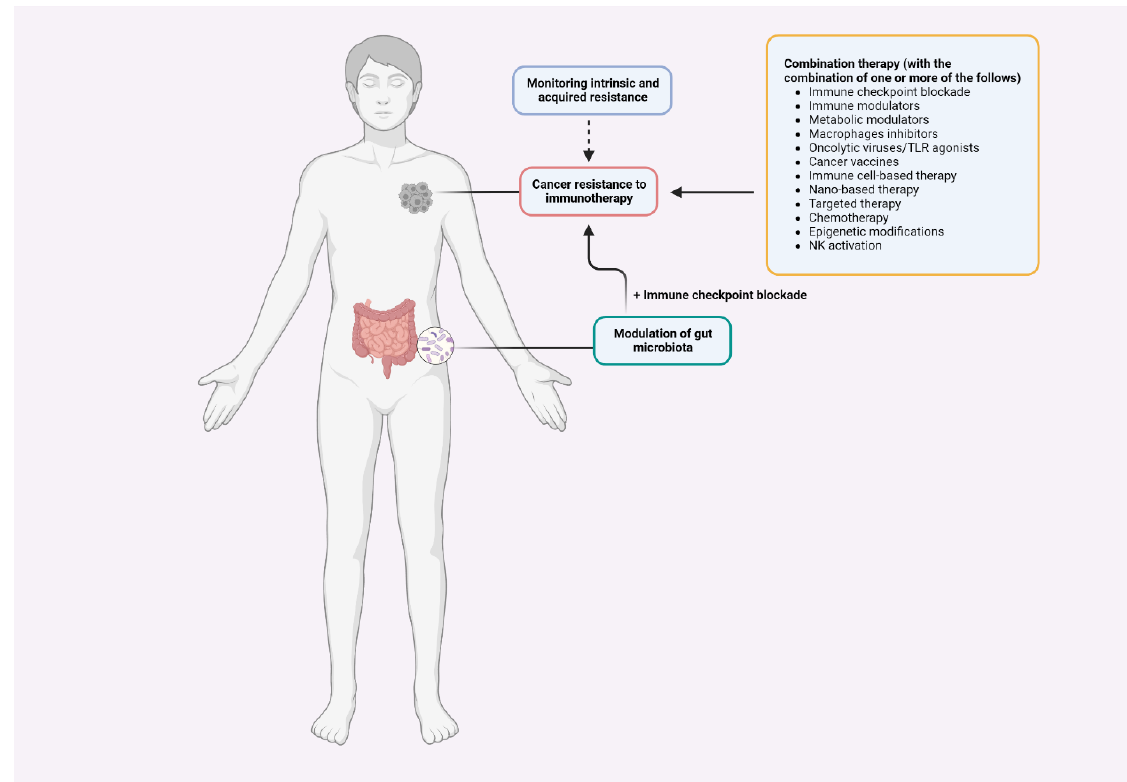
Figure 2. Tackling strategies. To tackle resistance effectively, tumors should be monitored followed by a number of therapeutic strategies such as combination therapy (see Table 1) and modulation of gut microbiota plus immune checkpoint blockade.